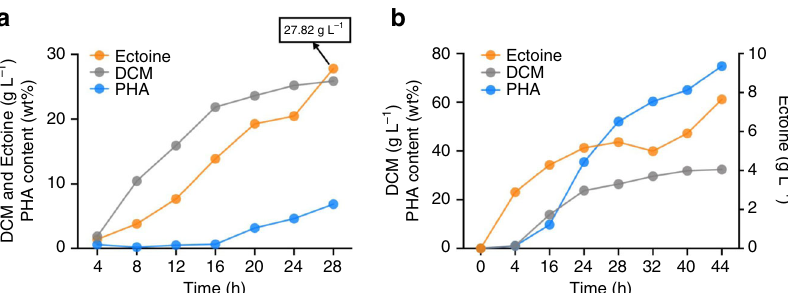
Fig. 7 Ectoine production by chromosomally engineered H. bluephagenesis TD-ADEL-58. a Growth, PHB and ectoine production by chromosomally engineered H. bluephagenesis TD1.0 strain TD-ADEL-58 fi ne-tuned with the ectoine biosynthesis pathway, including three individual expression units controlled by porin promoters of various strengths, respectively. b Co-production of ectoine and PHB by chromosomally engineered H. bluephagenesis TD1.0 (TD-ADEL-58). Nitrogen source in feeding solution Feed-I/II was reduced to enhance PHB accumulation compared to ( a ) with poor PHB accumulation. Data are generated from one fed-batch fermentation in a 7-L bioreactor under open unsterile conditions without means and error bars. Source data are provided as a Source Data fi